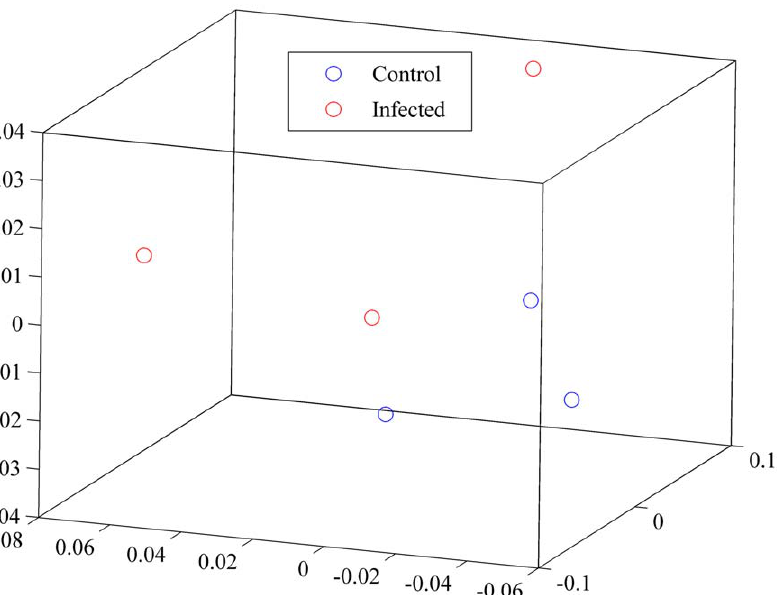
Figure 8. Principal Coordinates Analysis (PCoA) of weighted UniFrac values between control (blue) and infected (red) animals ( N =3): visualization in 3 dimensions (scaled).